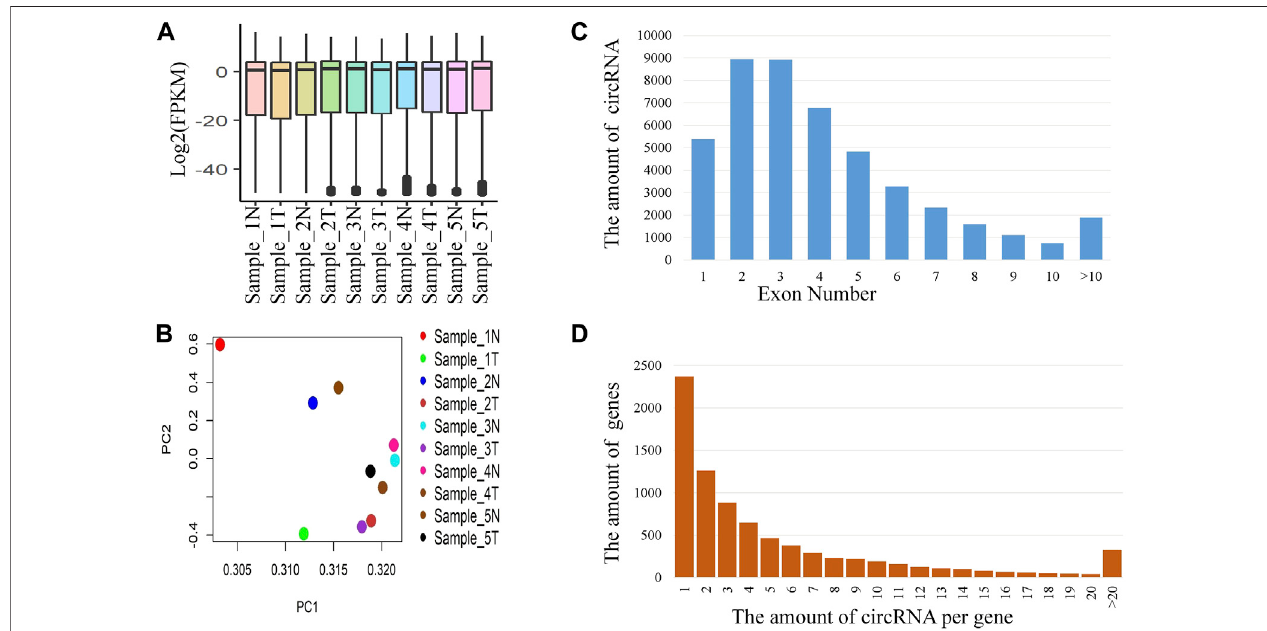
FIGURE 2 | Distribution of circRNAs. (A) Expression (FPKM) of circRNAs for different samples, (B) Biplot of PCA loadings for different samples, (C) Distribution of circRNAs derived from different number of exons, and (D) Distribution of the number of circRNAs per gene.